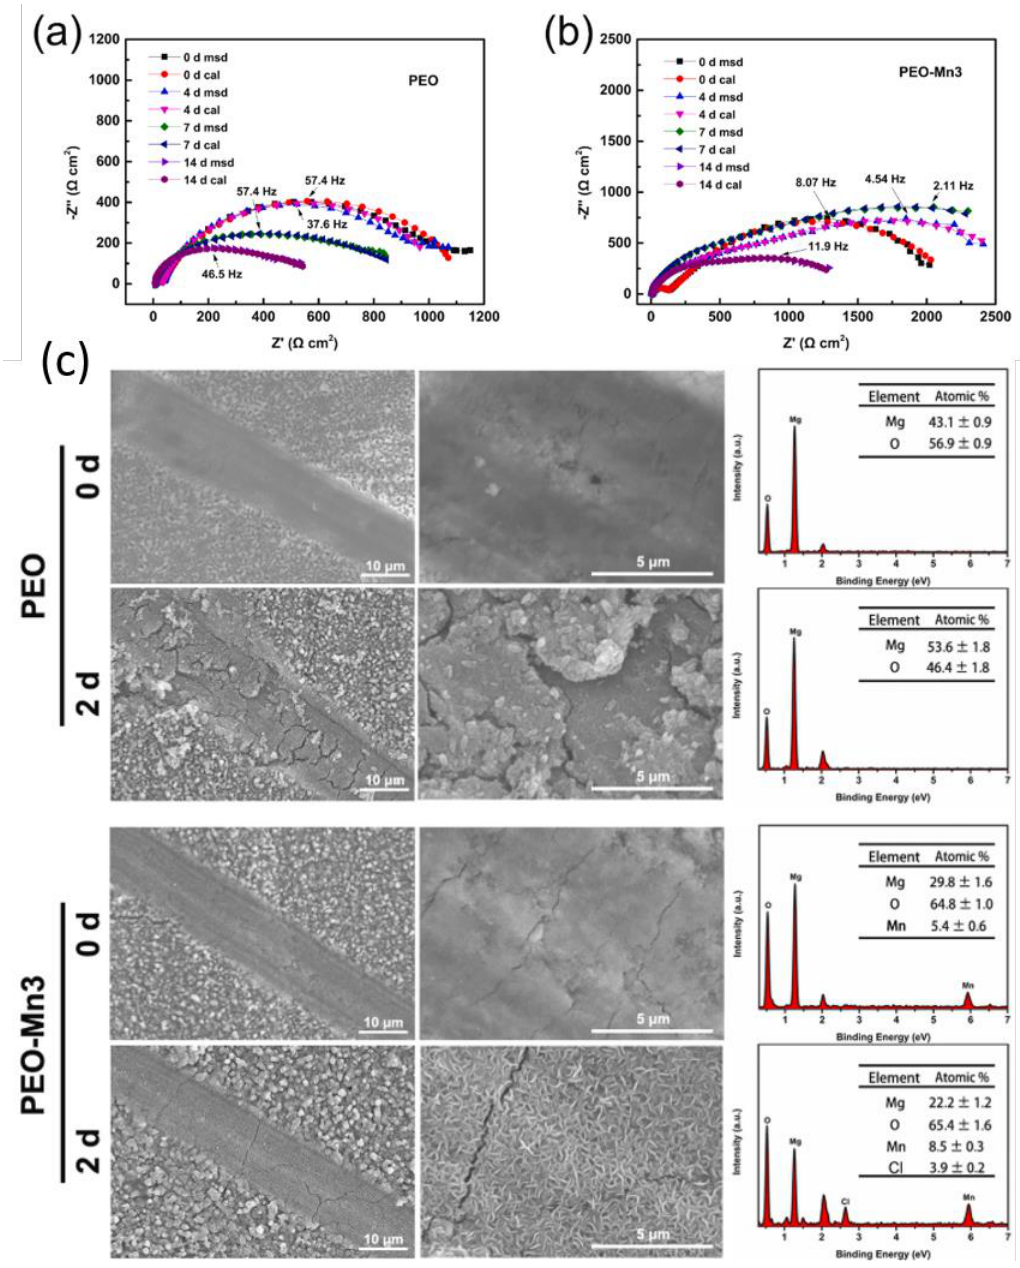
Figure 26. ( a ) Nyquist plots of the PEO sample without ( a ) and with ( b ) deposited MnOOH layer immersed in 0.9 wt.% NaCl solution for various times. ( c ) SEM surface views and EDS spectra of scratches area on the PEO sample without and with deposited MnOOH layer immersed in 0.9 wt.% NaCl solution for various times. PEO-Mn3 denotes the PEO-coated sample immersed in 12 g/L MnCl 2 for 9 h. Adapted [273] with permission from Elsevier.